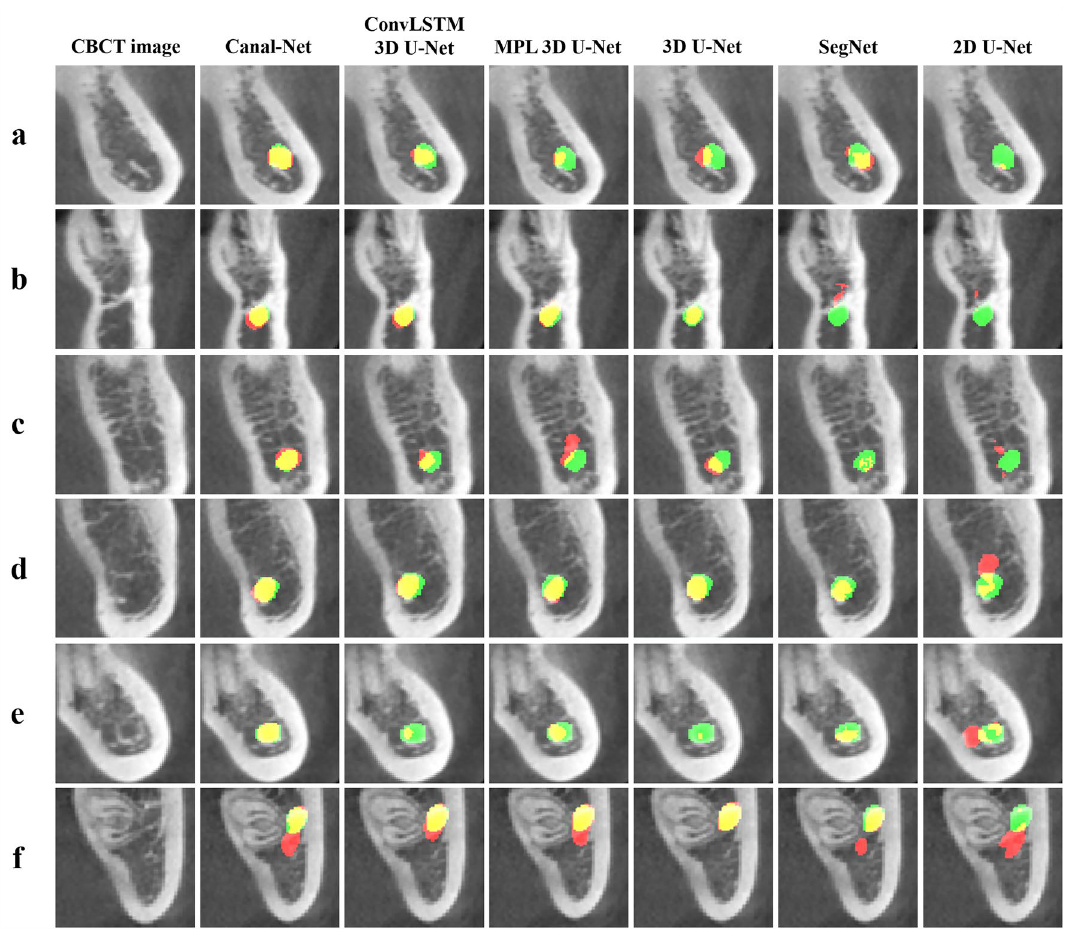
Figure 3. The segmentation results by Canal-Net (ours), ConvLSTM 3D U-Net (ours), MPL 3D U-Net (ours), 3D U-Net, SegNet, and 2D U-Net. The yellow, green, and red areas indicate the true positive, false negative, and false positive, respectively. The segmentation results for the MC with ( a–c ) low visibility and ( d,e ) containing the metallic crown and implant fixture, and for ( f ) the outlier of the Canal-Net in the boxplot in Fig. 2.